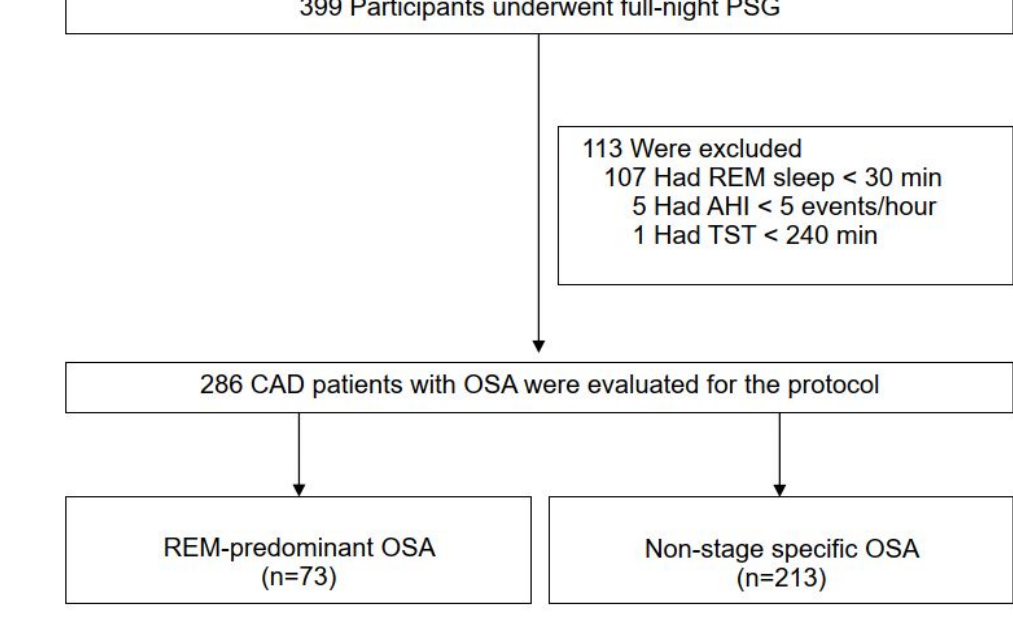
Figure 1. Consort flow chart of the study sample. Definition of abbreviations : AHI = apnea-hypopnea index; CAD = coronary artery disease; OSA = obstructive sleep apnea; PSG = polysomnography; REM =rapid eye movements; TST = total sleep time.